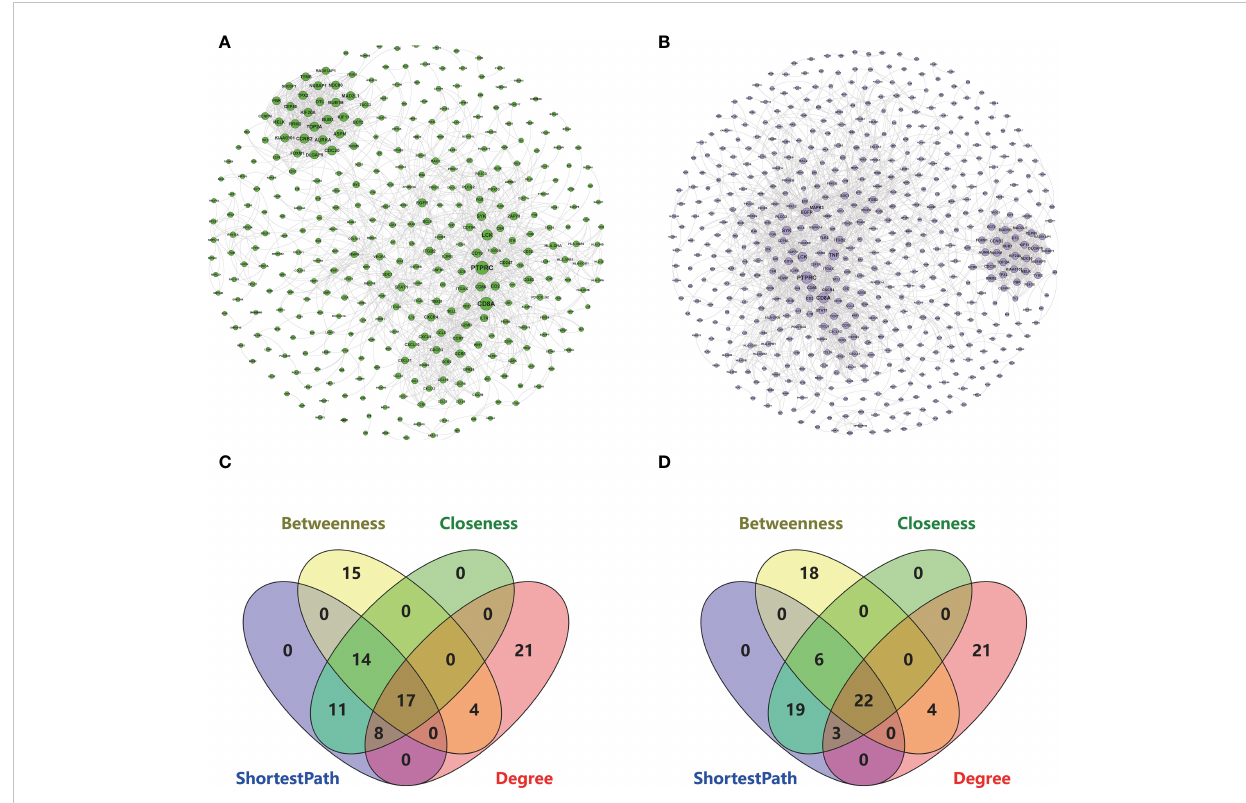
FIGURE 4 Based on the STRING database, 26 key genes were identi fi ed based on the two PPI network analysis in RA and MDD. (A) The left PPI network A is composed of genes in RA-MEyellow module and MDD-MEturquoise module (degree shown by node size). (B) The right PPI network B is composed of genes in RA-MEyellow module and MDD-MEblue module (degree shown by node size). (C) Screening of 17 key genes in the left PPI network A based on ShortestPath, Betweenness, Closeness, and Degree. (D) Screening of 22 key genes in the right PPI network B based on ShortestPath, Betweenness, Closeness, and